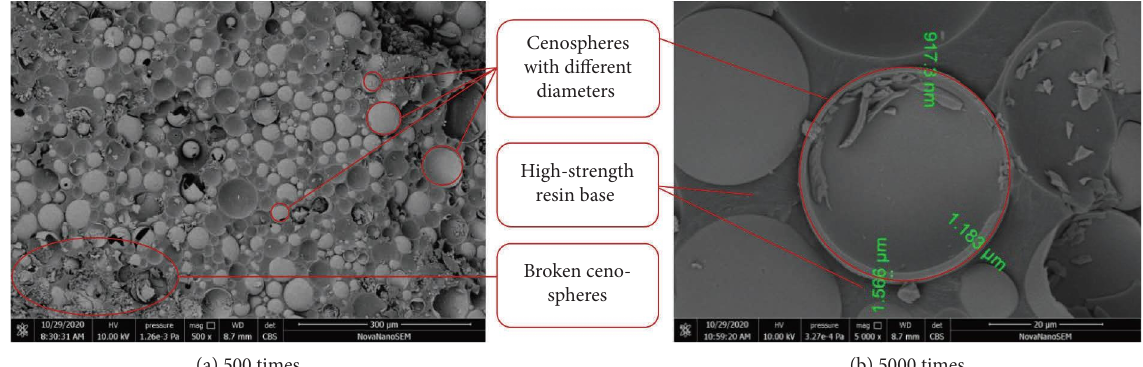
Figure 15: SEM image of buoyant material. (a) 500 times. (b) 5000 times.